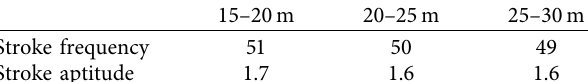
Table 2: Changes in stroke frequency and stroke width of athletes swimming under the VR model.